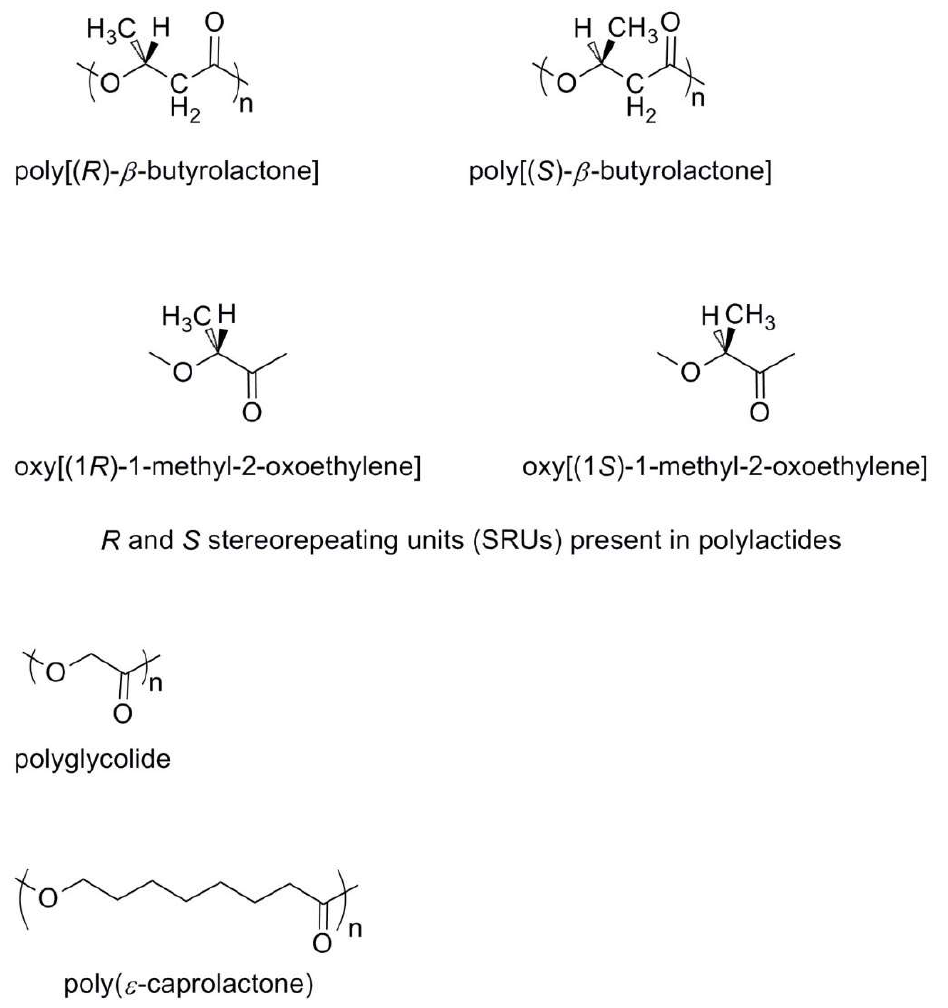
Scheme 7. Structure units of polyesters commonly used for preparation of drug nanocarriers. Terminology of polylactide structure units is based on IUPAC recommendations [88].